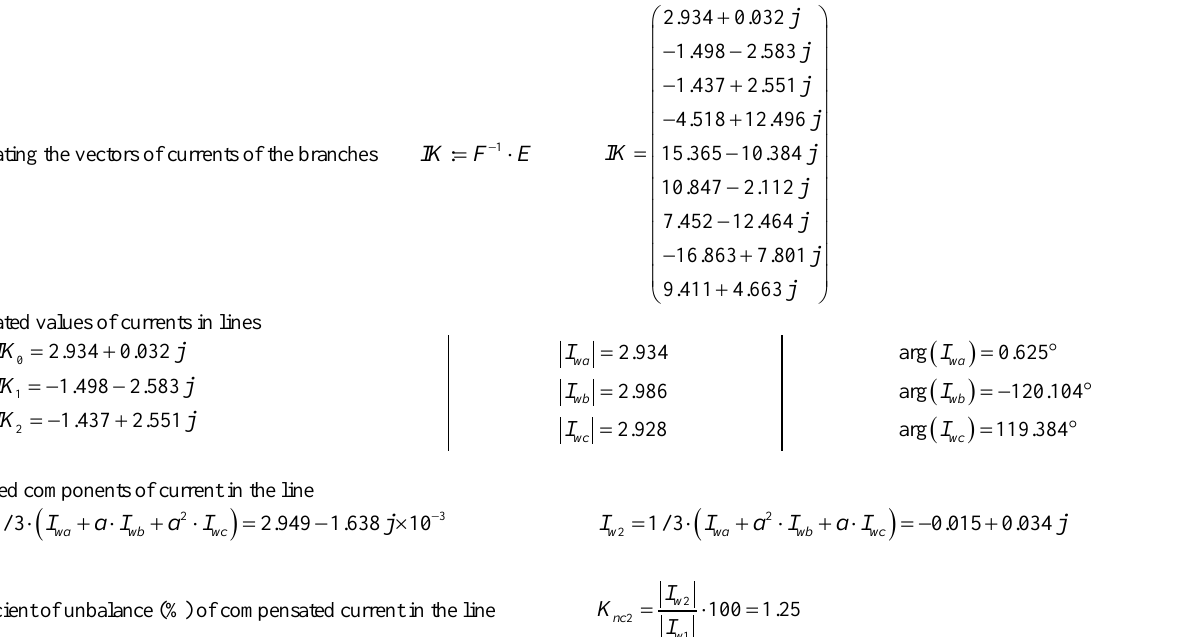
Table 4. Calculation and assessment of coefficient of lines currents unbalance with the parameters of initial